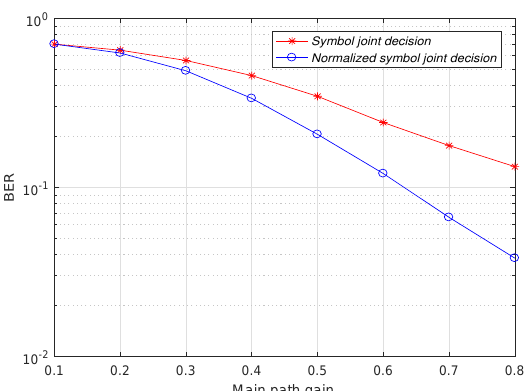
Figure 10. Bit error rate comparison of normalized symbol joint decision and symbol joint decision after fixed sub-path gain.